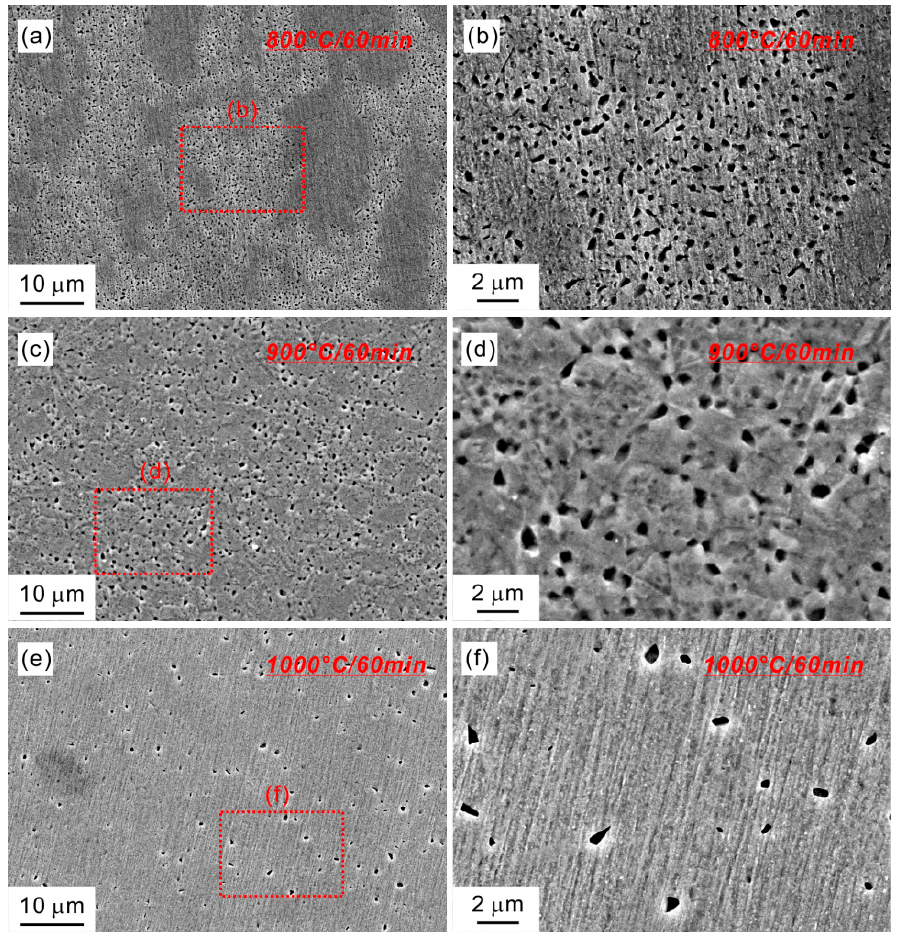
Figure 5. SEM micrographs of HEA specimens annealed at ( a ) 800 °C, ( c ) 900 °C, and ( e ) 1000 °C. ( b,d , f ) are magnified images in boxed regions of ( a , c , e ).